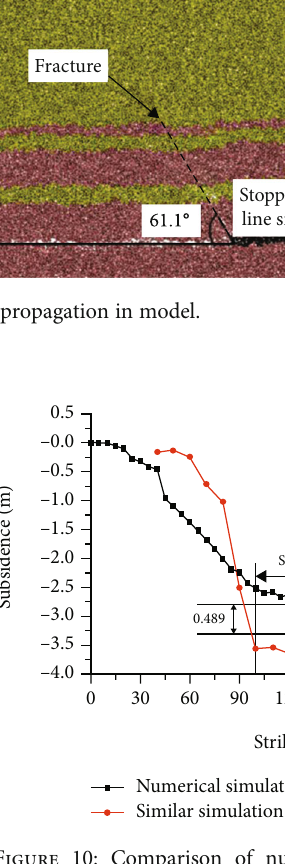
Figure 9: Subsidence curves at di ff erent positions above coal seam.